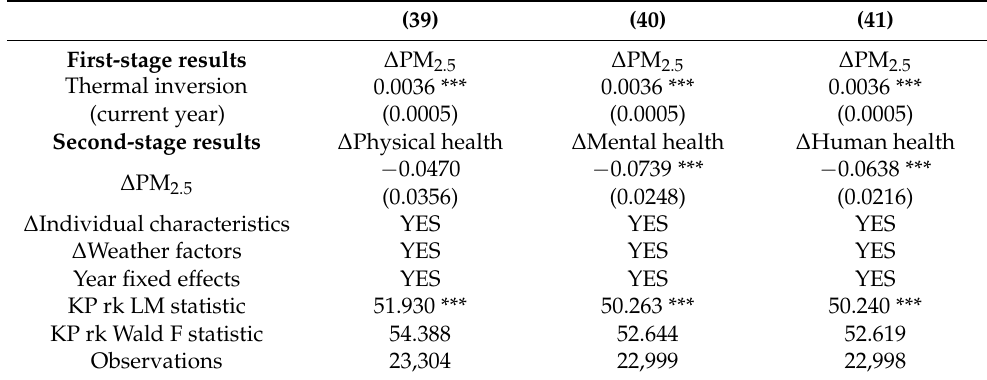
Table 12. LD estimates of influence of air pollution on physical, mental, and human health (six years).